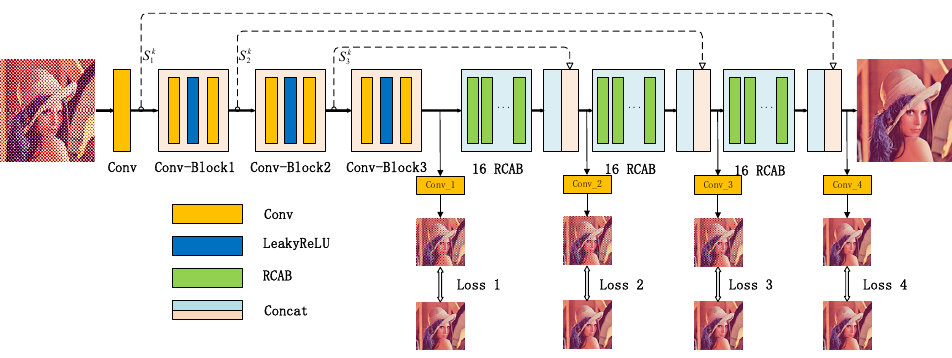
Figure 1. The proposed network architecture.